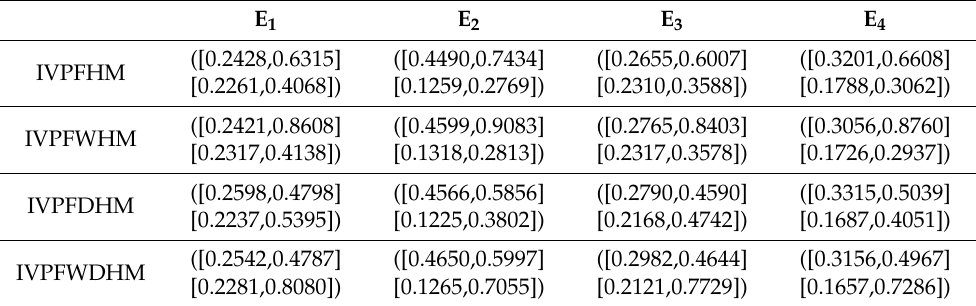
Table 3. The aggregation result of IVPFHM, IVPFWHM, IVPFDHM, and IVPFWDHM